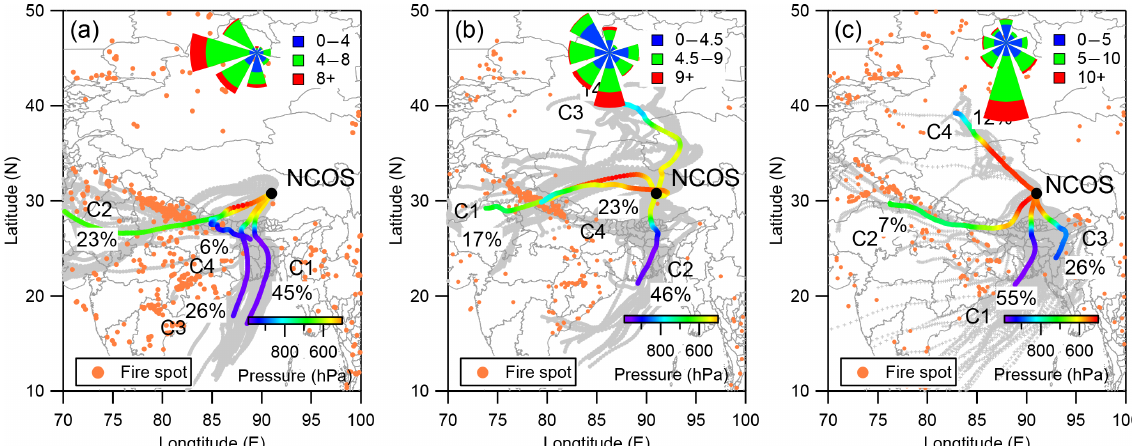
Figure 3. 72h backward air mass trajectory and class statistics over Nam Co station for (a) P1, (b) P2, and (c) monsoon period. The back trajectories at 1000m above ground level were calculated at 1h intervals using the NOAA Hybrid Single Particle Lagrangian Integrated Trajectory (HYSPLIT) model (Draxler and Hess, 1998) and 1 ◦ resolution Global Data Assimilation System (GDAS) data set (https://ready. arl.noaa.gov/gdas1.php). The classes of trajectories are colored according to pressure. Fire spot observed by MODIS (https://firms.modaps. eosdis.nasa.gov) and average wind rose plot during each period are also shown.